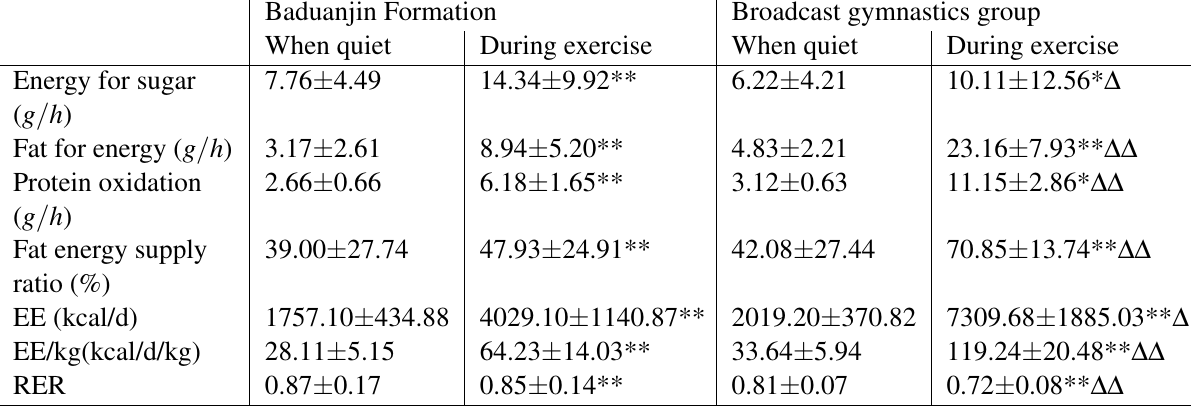
Table 3 Energy consumption and metabolic substrate measurement results in different